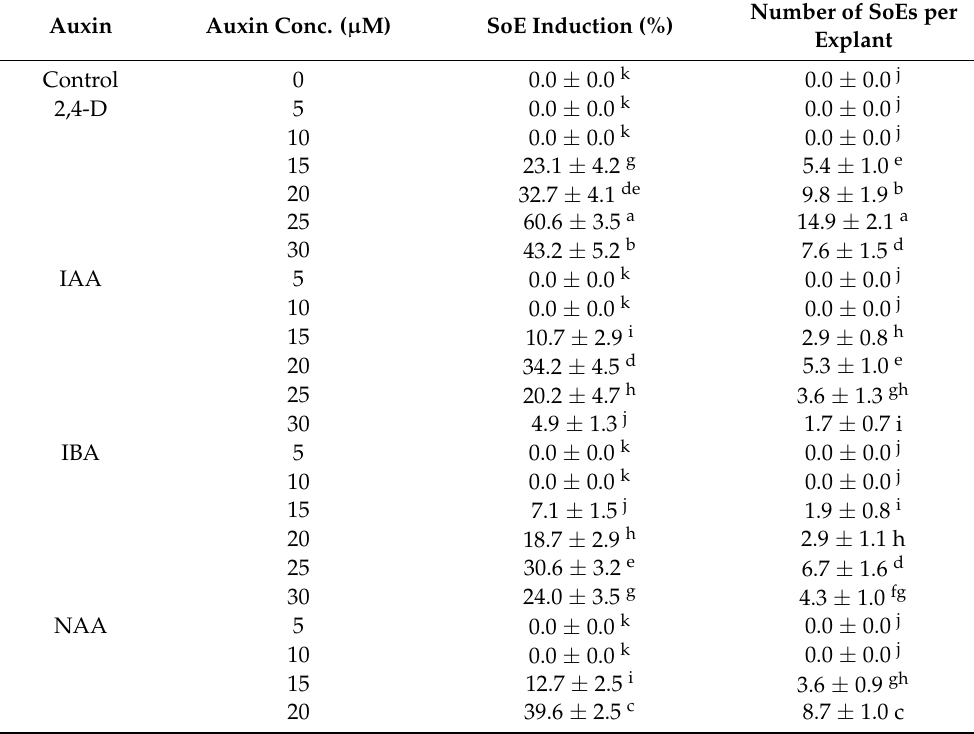
Table 1. Impact of auxins on SE in C. orbiculata . Auxin Auxin Conc. ( µ